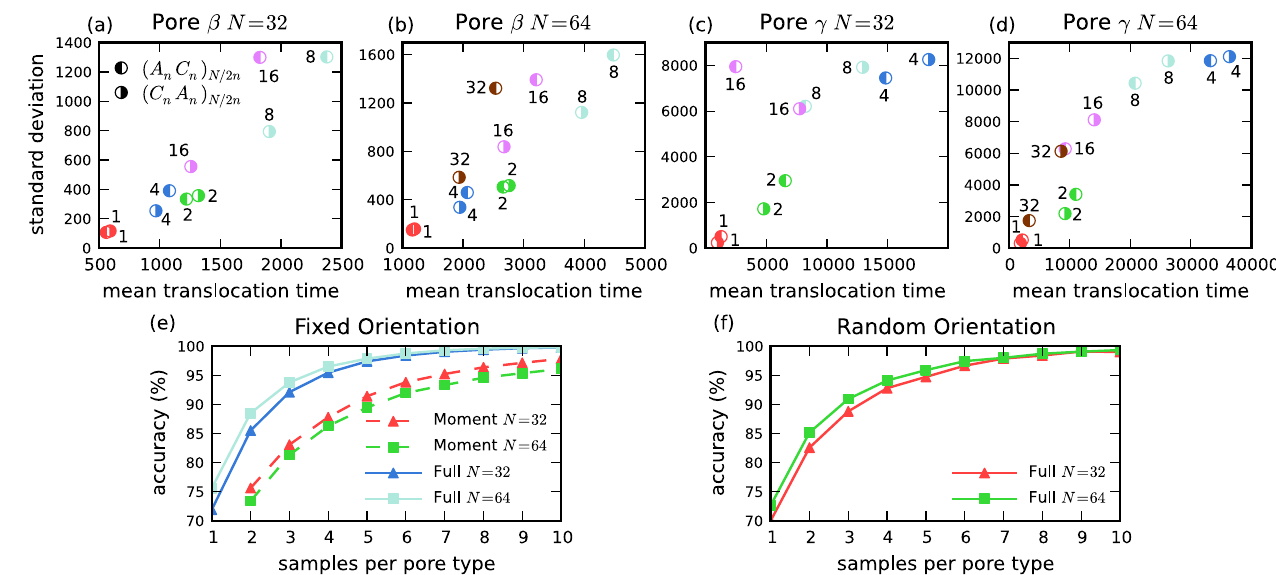
FIG. 4. Using translocation time statistics to detect polynucleotide sequences. (a), (b), (c), and (d) Scatter plots showing the distinctive mean and standard deviations of the different sequences and for different ends of the polynucleotide entering the pore. The p ffiffiffiffiffiffiffiffiffiffiffiffiffiffiffiffiffiffiffiffiffiffiffi h (cid:6) 2 i (cid:1) h (cid:6) i 2 , for the different sequences are calculated from the distributions. mean translocation time, h (cid:6) i , and its standard deviation, The scatter plots reveal the distinctive characteristics of the translocation events for the different sequences through each pore. The plots correspond to (a) Pore (cid:3) with F ¼ 1 : 0 and N ¼ 32 ; (b) Pore (cid:3) with F ¼ 1 : 0 and N ¼ 64 ; (c) Pore (cid:4) with F ¼ 0 : 5 and N ¼ 32 ; and (d) Pore (cid:4) with F ¼ 0 : 5 and N ¼ 64 . (e) and (f) Accuracy of sequence detection using multiple joint translocation events through Pores (cid:3) and (cid:4) . The plots are constructed by recording a given number of translocation times through Pores (cid:3) and (cid:4) , and using a comparison with either the full distribution or the first two moments of the distribution shown in the scatter plots (a, b, c, and d). For the method that uses the moments, the sample average and standard deviation are calculated and used to find the relative error of the sample average and standard deviation compared to the known values and compound them into an error metric for each pore and each sequence. The error metric is subsequently used for each pore to define a closeness metric, which will be minimized to predict the sequence. The accuracy is the ratio between the number of successful predictions and the total number of attempts. In (e) the orientation of the polymer is known and preserved when it passes through the different pores. In (f) the orientation of the polymer is not known and randomly changes when it passes through the different